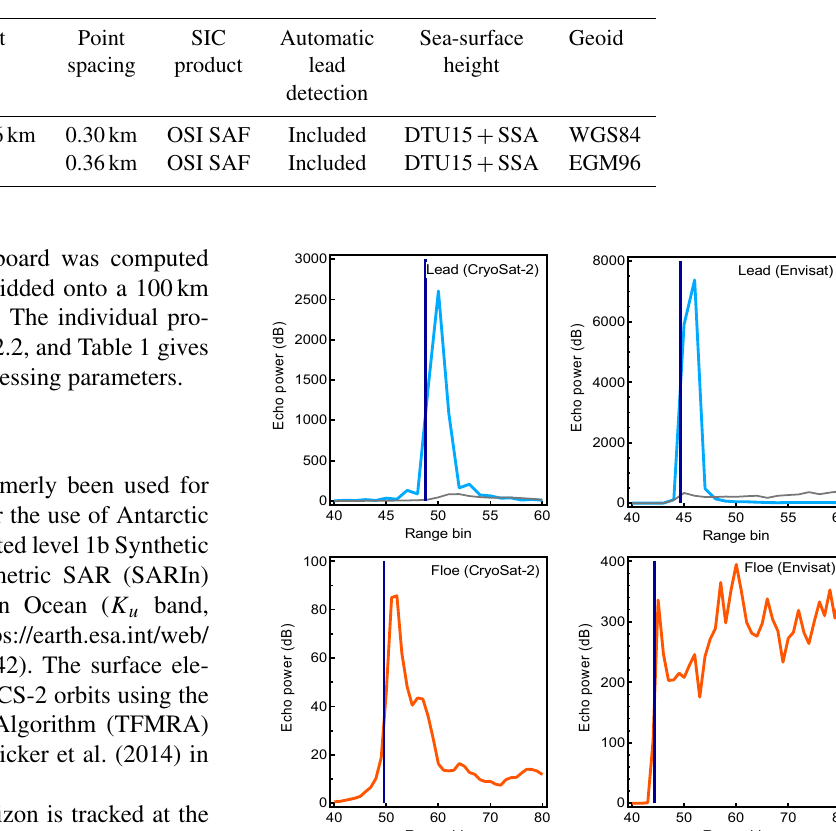
Table 1. Comparison between characteristics of Envisat and CS-2 and the processors used for freeboard calculations. SSA is sea-surface anomaly derived from detected leads; SIC is sea-ice concentration.